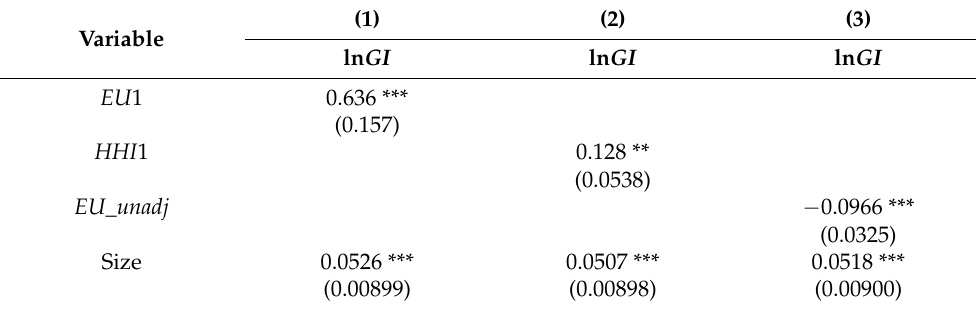
Table A3. Robustness Analysis of Environmental Uncertainty and Enterprises’ Green Technological